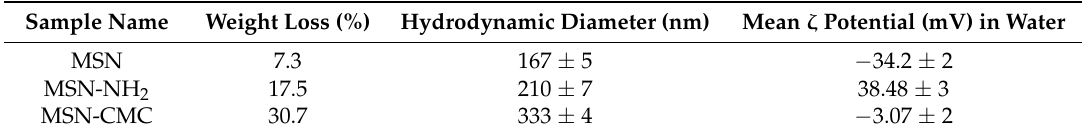
Table 1. Physical properties of various MSNs.